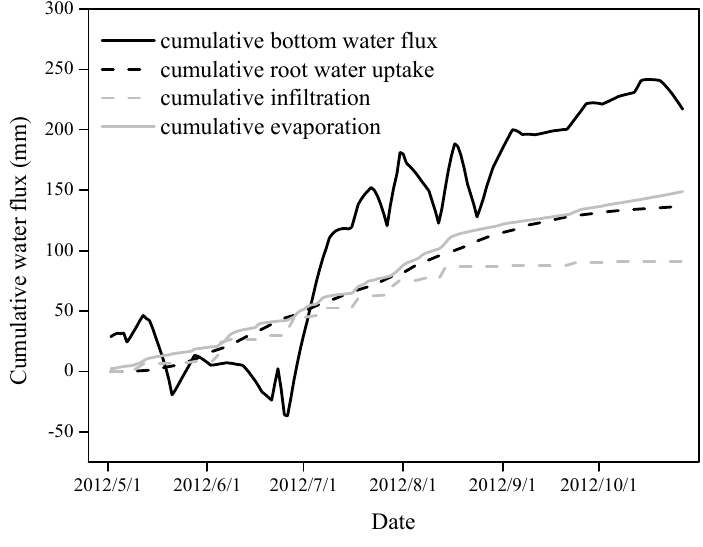
Figure 4. Cumulative water flux during the growing season of